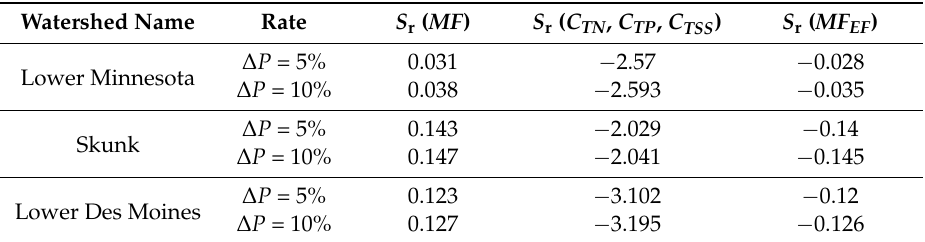
Table 3. Average S r between 1995 and 2013 for MF , MF EF and concentrations of water quality constituents ( C TN , C TP , C TSS ).